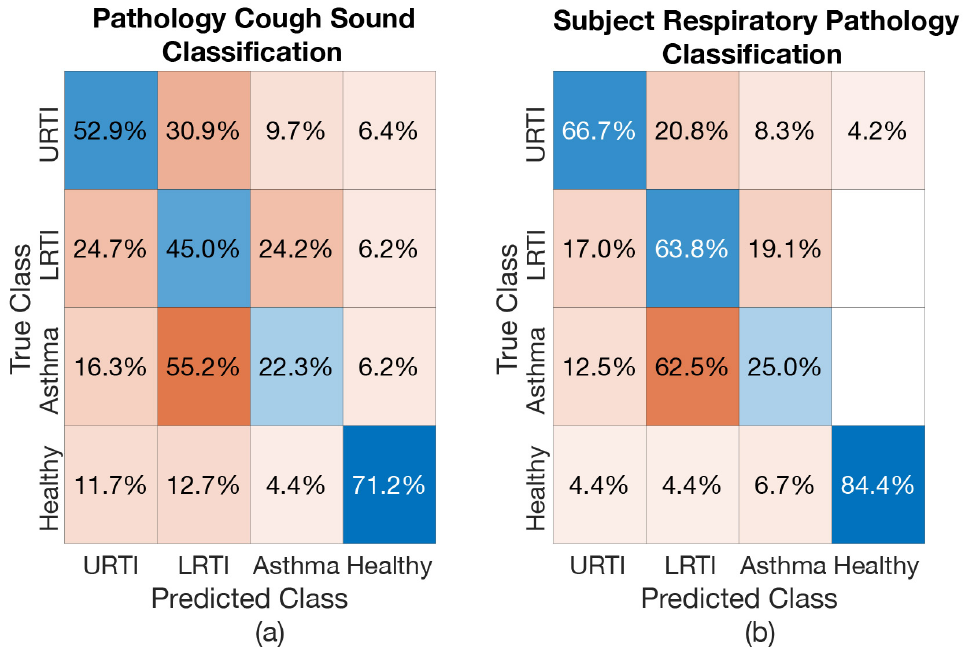
Figure 14. Confusion Matrix— Healthy vs. Pathology (4-Class) Model : ( a ) when screening coughs, ( b ) when screening for pathology of the subjects. Table 7. Cough classification accuracy of Healthy vs. Pathology 4-Class Model .